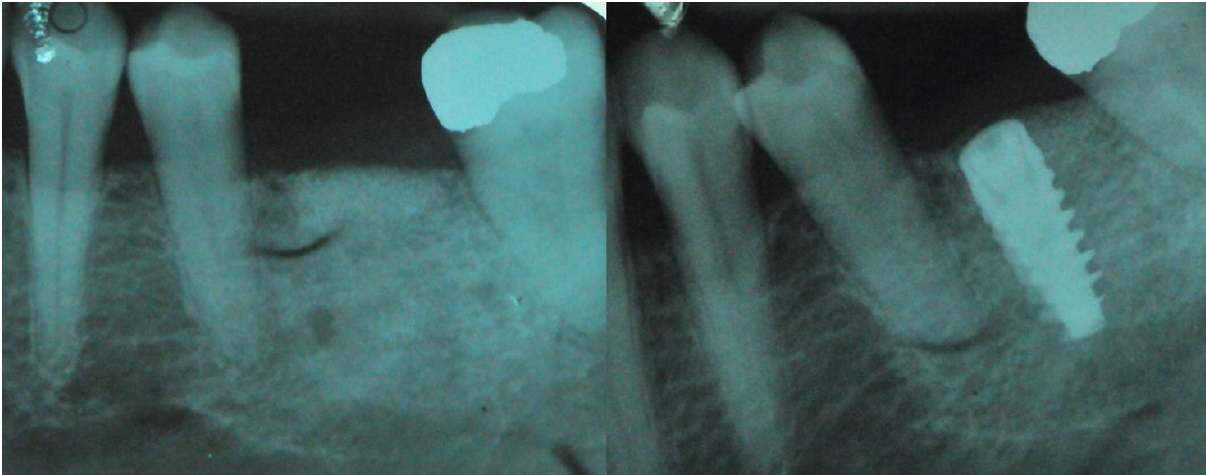
Figure 5. Intra oral radiograph before and after implant placement. Left: intra-oral X-ray after grid removal and healing occurred. Right: fixture installation.